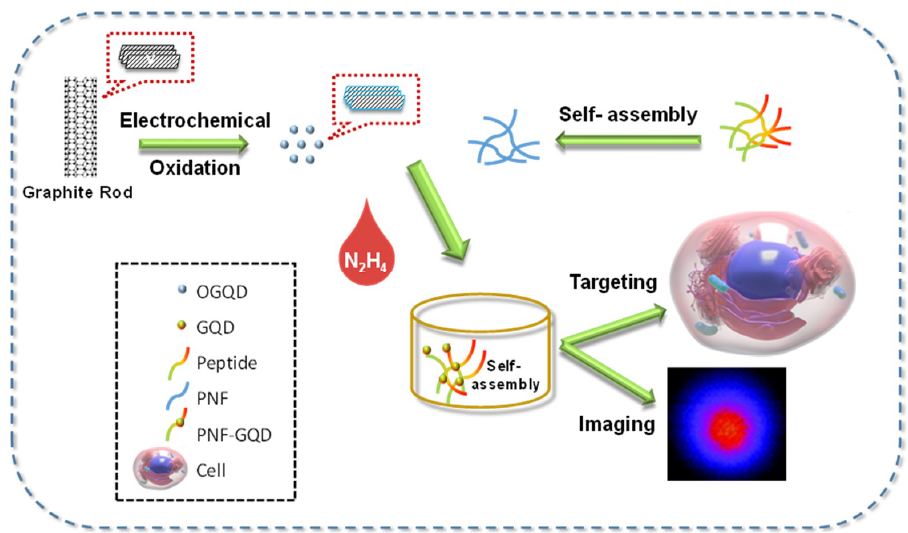
Figure 8. Schematic representation of the study in brief. The graphite rods were electrolyzed to the oxidized GQDs (OGQDs) and GQDs were synthesized by hydrazine hydrate reduction from OGQDs. Highly crystalline GQDs had 2–3 graphene layer with 0.25 nm lattice spacing. The peptide was designated to have AEAK sequence (for the self‐assembly), RGD sequence (bind to integrins of the tumor), and YWYAF sequence (can bind to graphene). Subsequent to self‐assembly, the PNFs were obtained with the height of 0.2–0.5 nm. Afterward, PNF–GQD nanohybrids were formed and were